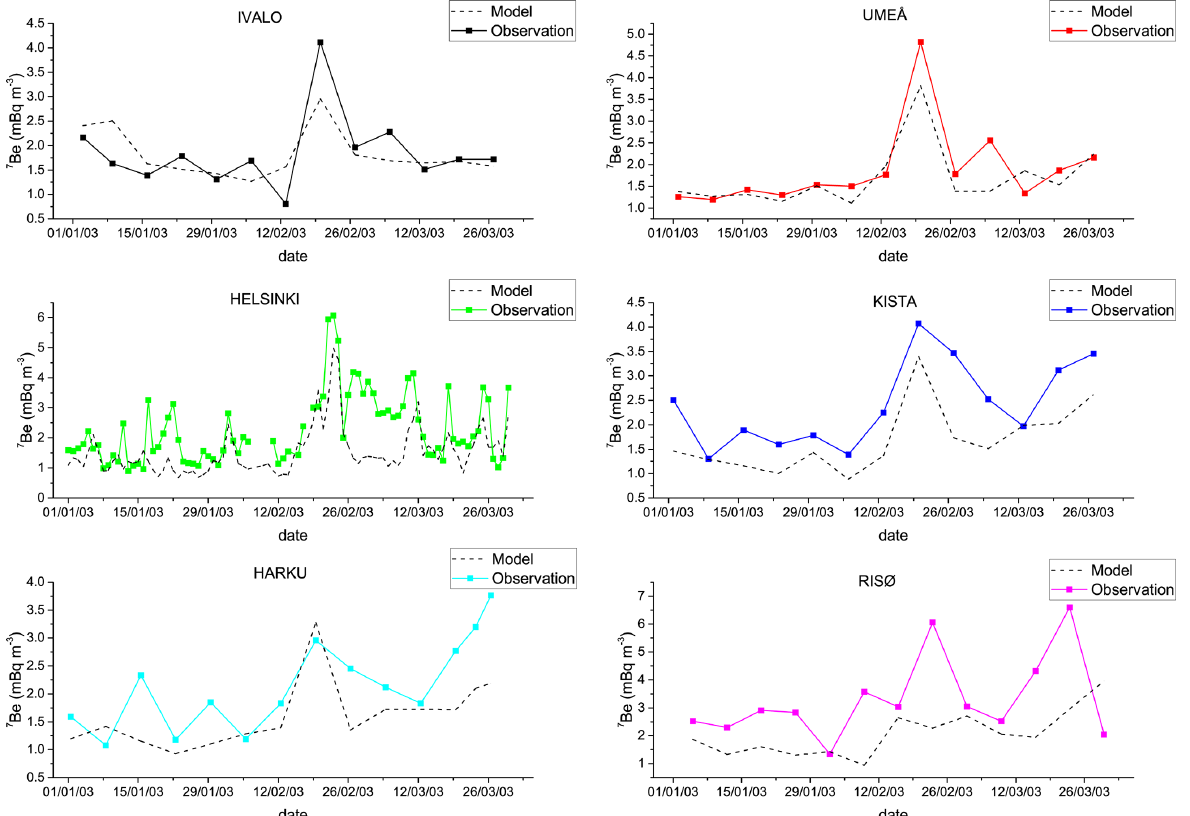
Figure 5. Temporal evolution of simulated and observed 7 Be surface concentrations at the six sampling sites. Values are weekly (daily in the case of Helsinki) means.